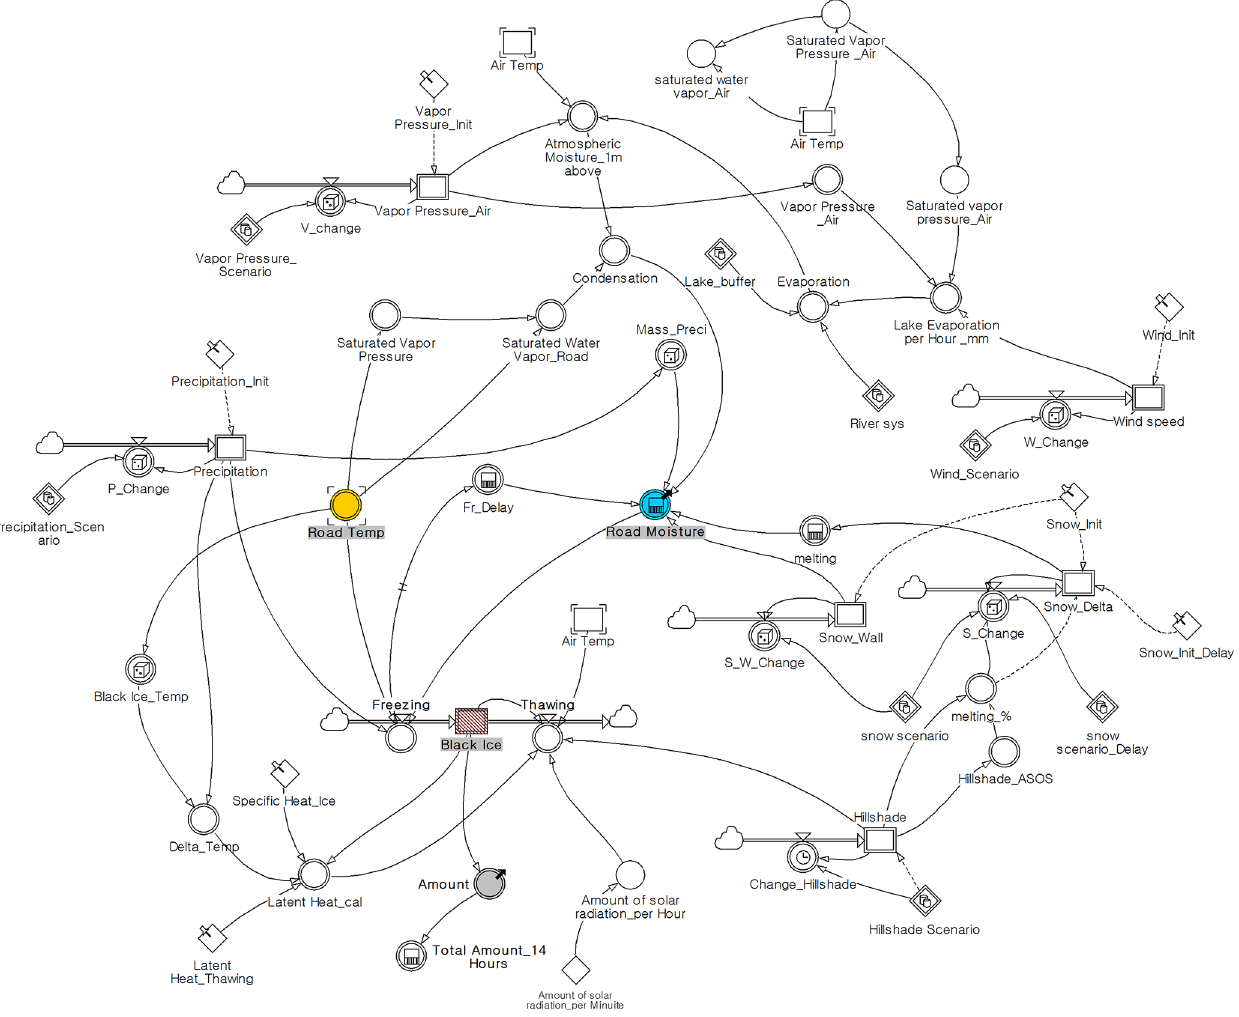
Figure A1. Block diagram of the system dynamics